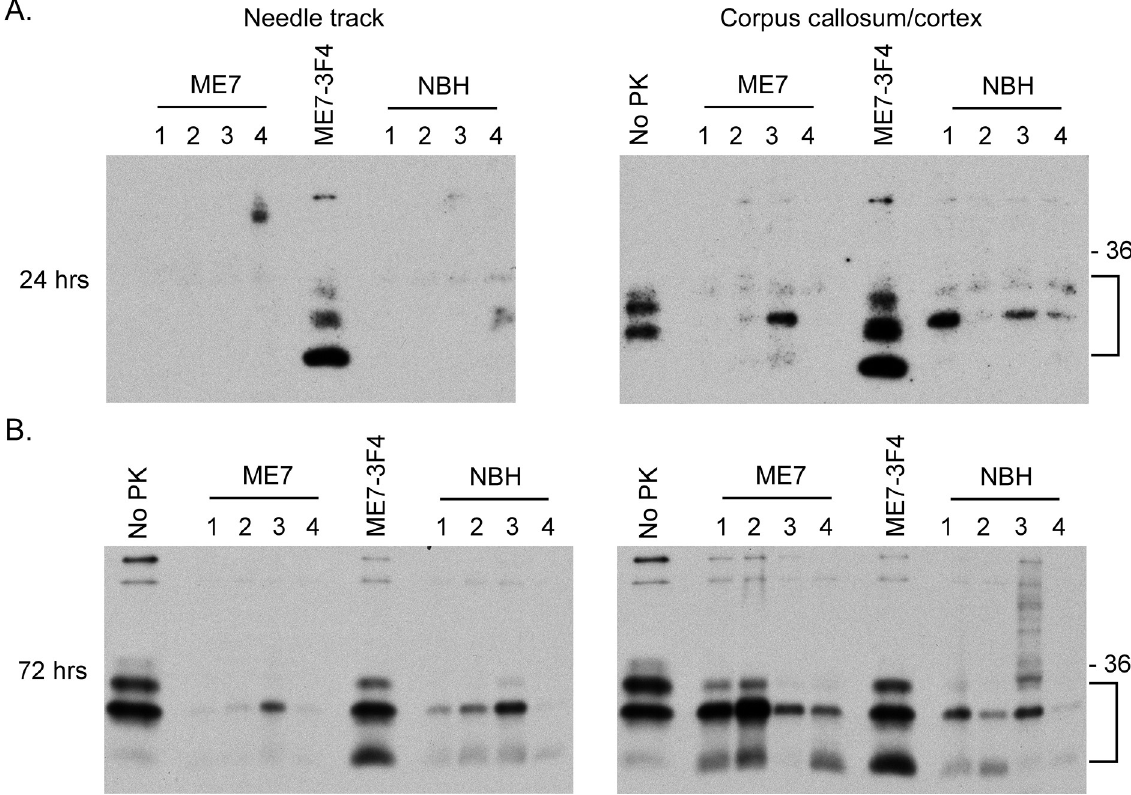
Fig 5. Protease resistant PrP-3F4 is present in the brains of mice inoculated with ME7 prions or NBH. Brain tissue dissected at (A) 24 hrs or (B) 72 hrs post-inoculation from either the tissue adjacent to the needle track (needle track, left panels) or the corpus callosum and adjacent cortical tissue (corpus callosum/cortex, right panels) was homogenized, PK-digested, and PNGaseF treated as described in the Materials and Methods. For each inoculum, tissue from 4 individual mice was assayed (lanes numbered 1–4). Lanes marked No PK show PrP-3F4 in brain tissue from uninoculated Tg3F4 mice that was PNGaseF treated but not digested with PK. Lanes labeled ME7-3F4 show PrP Sc -3F4 in PK- digested, PNGaseF treated brain tissue from a clinically positive Tg3F4 mouse inoculated with ME7 prions. The 36kDa molecular mass marker is shown on the right and the bracket indicates PrP-3F4 specific bands. Blots were developed using a biotinylated form of the anti-PrP mouse monoclonal antibody 3F4.